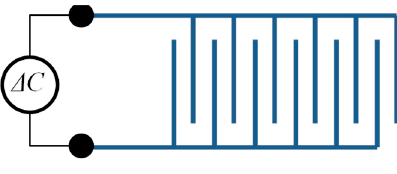
Figure 27. Capacitive strain gauge.